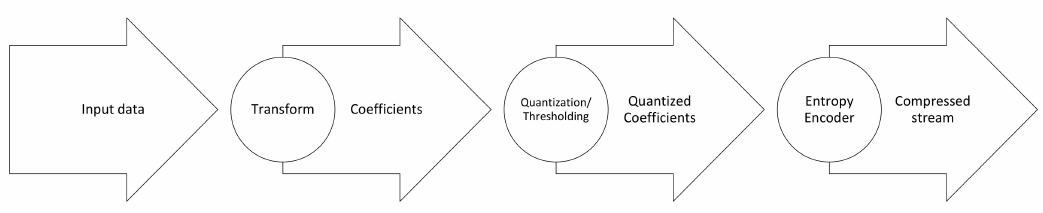
Figure 11. Main steps in the transform-based compression class of